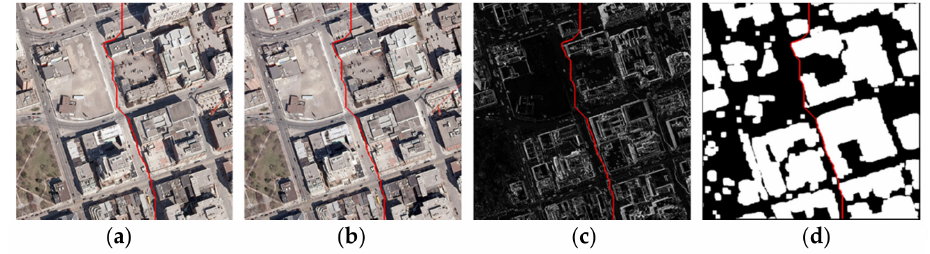
Figure 11. Overlaid display of the seamline (red lines) extracted by the proposed method on different image subsets. ( a ) Original left digital ortho map (DOM); ( b ) original right DOM; ( c ) the difference image; ( d ) the processed DSM.